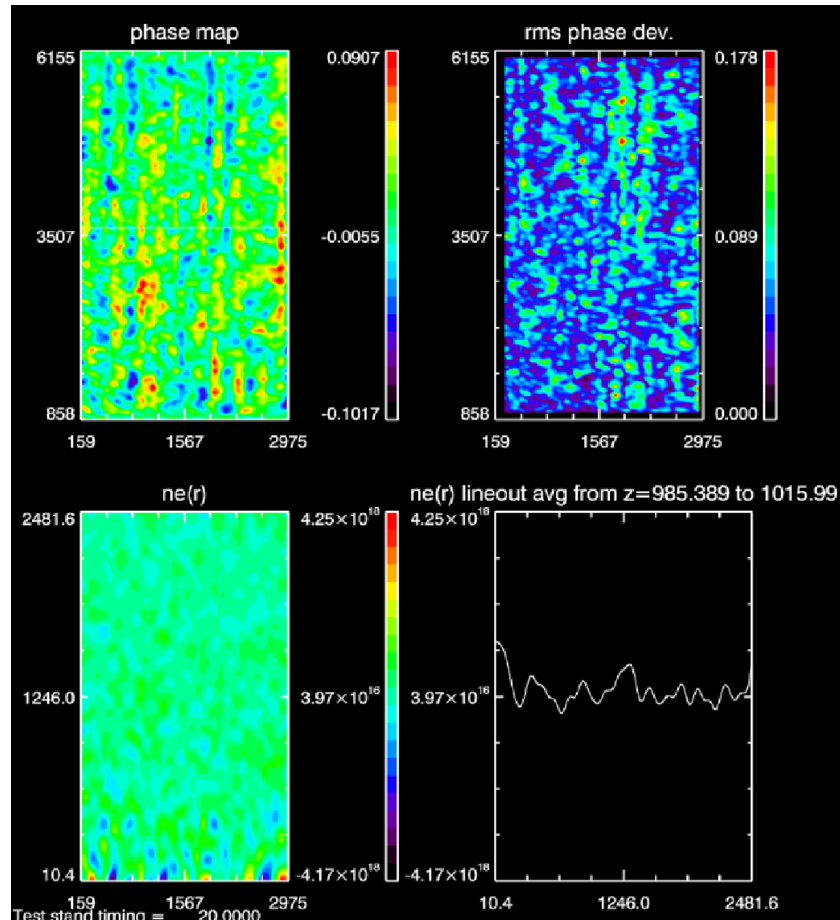
FIG. 16. Interferometer data from a He jet produced by the MOC nozzle at 615 psia = 500 V . Data snapshot at 20 (cid:1) s after valve is fired (no gas flow as yet). The top left is the phase map, the top right is the rms phase deviation; the bottom left is the derived (Abel inverted) density map and the bottom right is a ‘‘lineout’’ at about 1 mm from the nozzle